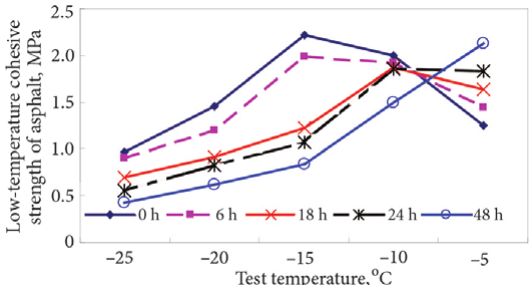
Figure 10. Influence of the ageing effects on the peak time of PE-modified bitumen low-temperature cohesive